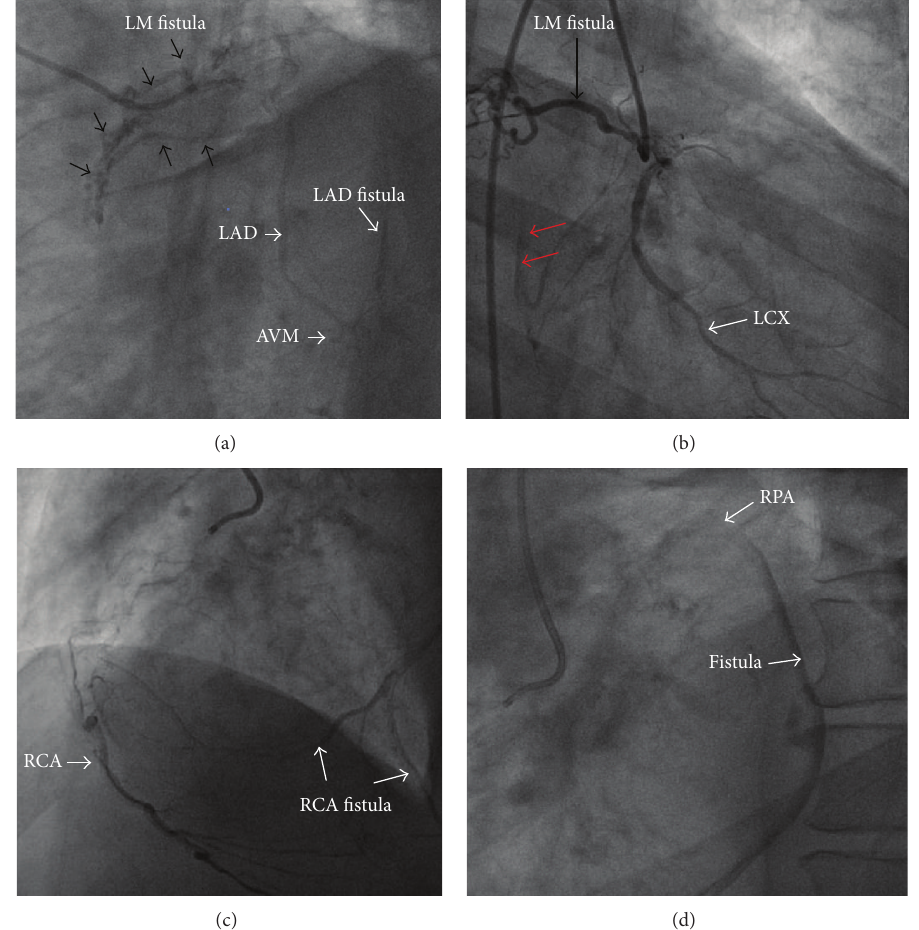
Figure 2: (a) Still-frame image of late filling of coronary angiogram to left system with selective engagment of the LAD showed LM fistula (black arrows) which join the fistuous vessel of the other coronary artery and then drainage to the right pulmonary artery (RPA). (b) Still- frame image of cornonary angiogram to left system with selective engagement of the LCX and LM fistula (black arrow) fistolous vessel fills from the LCX (red arrow). (c) Still-frame image of cornonary angiogram of the RCA shows the fistolous vessel fills from RCA. (d) The same injection with late filling shows the fistula drainge to RPA. LAD: left anterior descending. LCX: left cercumflex. LM: left main. RAC: right coronary artery. RPA:right pulmonary